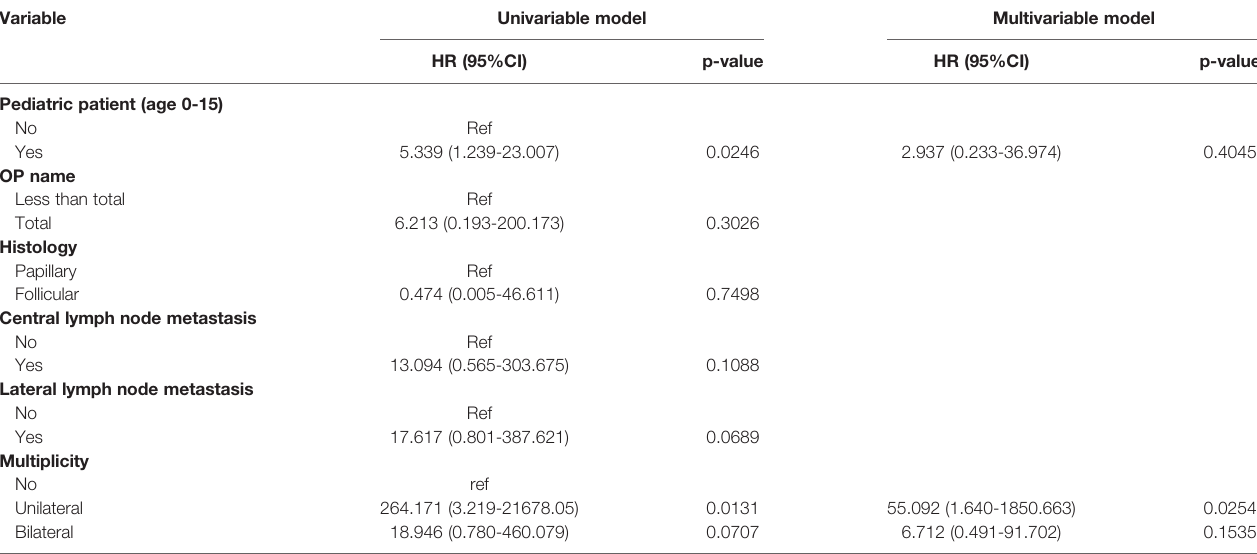
TABLE 3 | Strati fi ed Cox regression to evaluate risk factors for